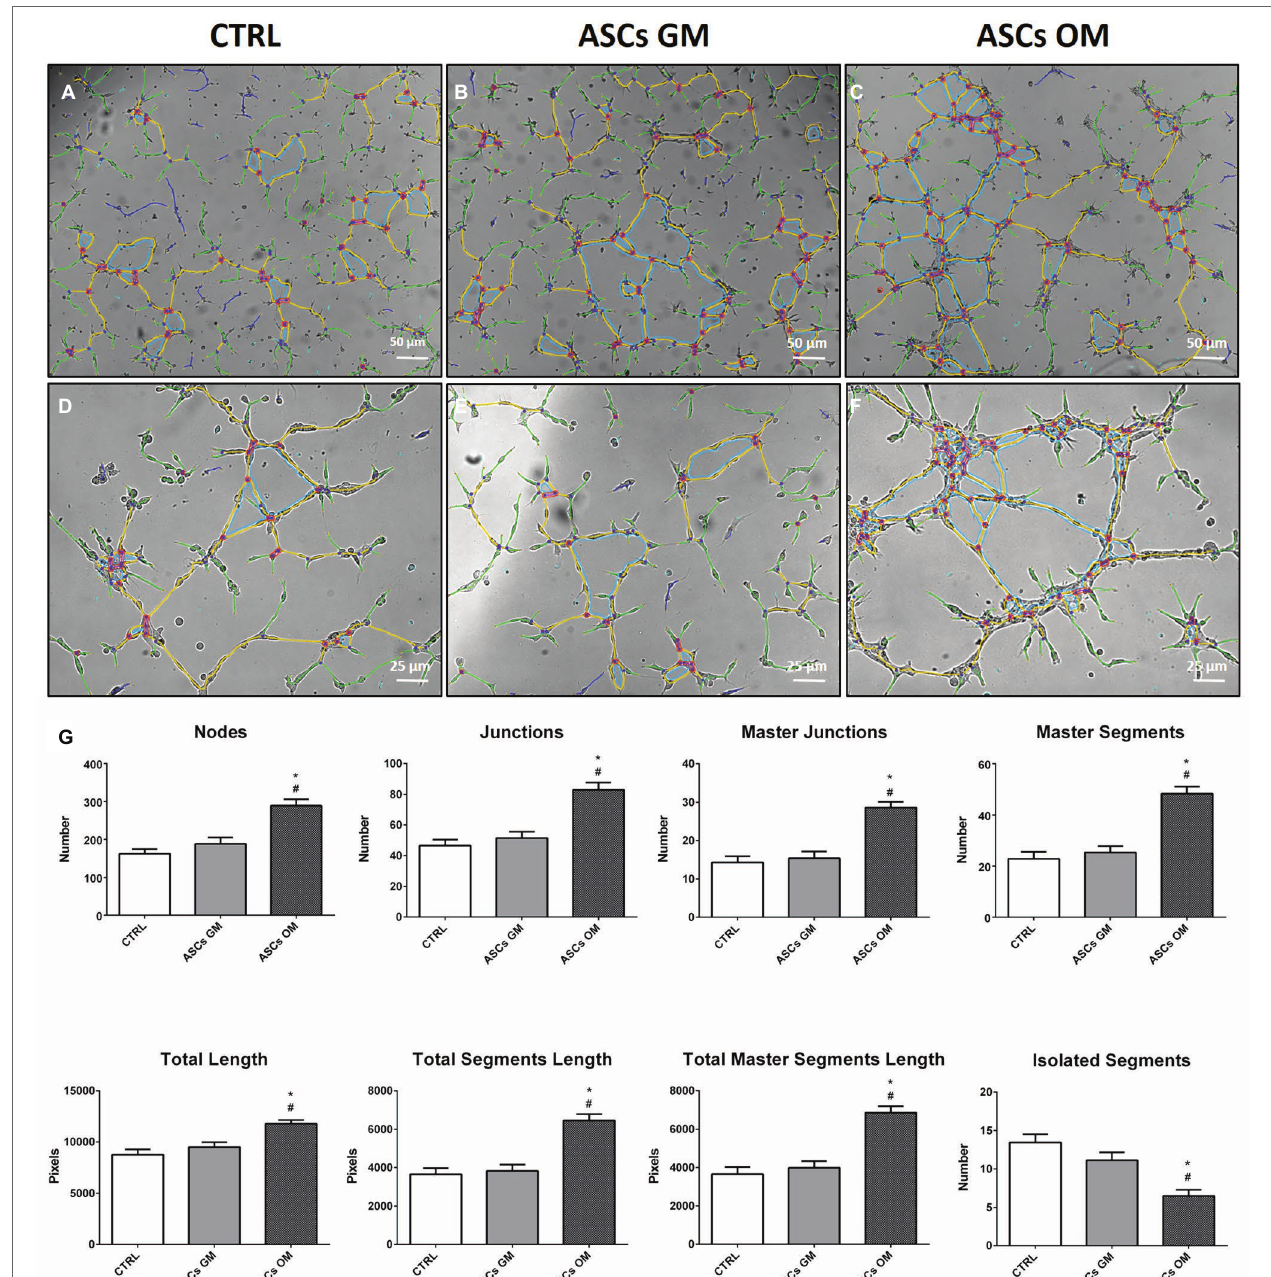
FIGURE 3 | Evaluation of the angiogenic potential of HMECs in the presence of ASCs. (A–F) Representative pictures of in vitro tubulogenesis assay performed on endothelial cells alone (CTRL) or upon co-culture with ASCs. The formation of capillary-like structures was performed on Matrigel coating and analyzed after 8 h using ImageJ’s Angiogenesis Analyzer tool. The quantification of main parameters describing the capillary network complexity is reported in (G) CTRL, HMECs without ASCs; ASCs GM, HMECs co-cultured with undifferentiated ASCs; ASCs OM, HMECs co-cultured with osteodifferentiating ASCs. The symbol (*) indicates a statistical significance vs. the CTRL condition; the symbol (#) indicates a statistical significance of the ASCs GM condition compared to ASCs OM condition, considering a p <